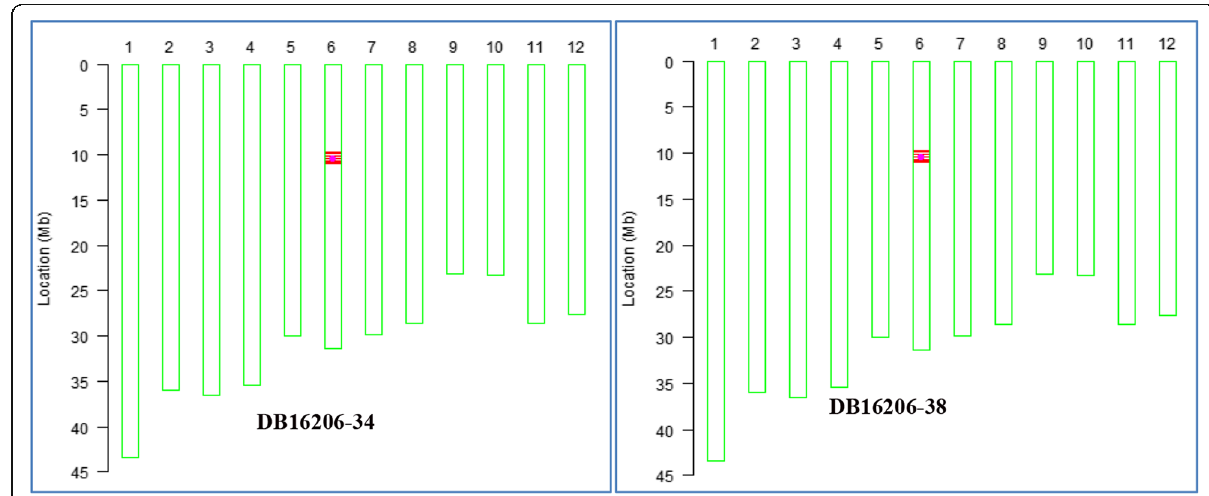
Fig. 2 Genetic background analysis of the two selected lines of BC 2 F 2 detected by RICE6K chip. The pink dots indicate the positions of the Pi2 locus on chromosome 6. The red lines indicate the SNP loci with homozygous genotypes where genomic fragments of the donor parent Hua1201S were